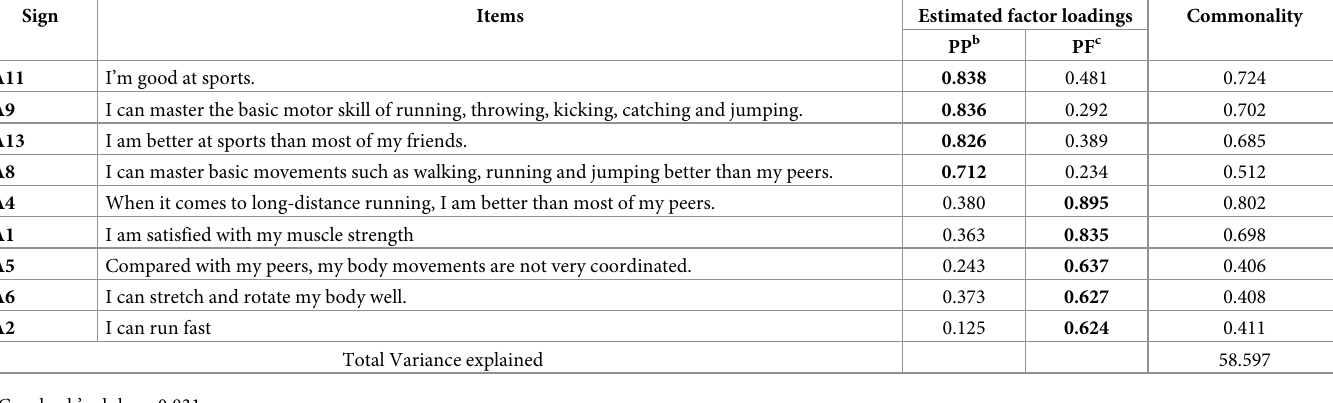
Table 7. Factor structures of physical competence by exploratory factor analysis a .